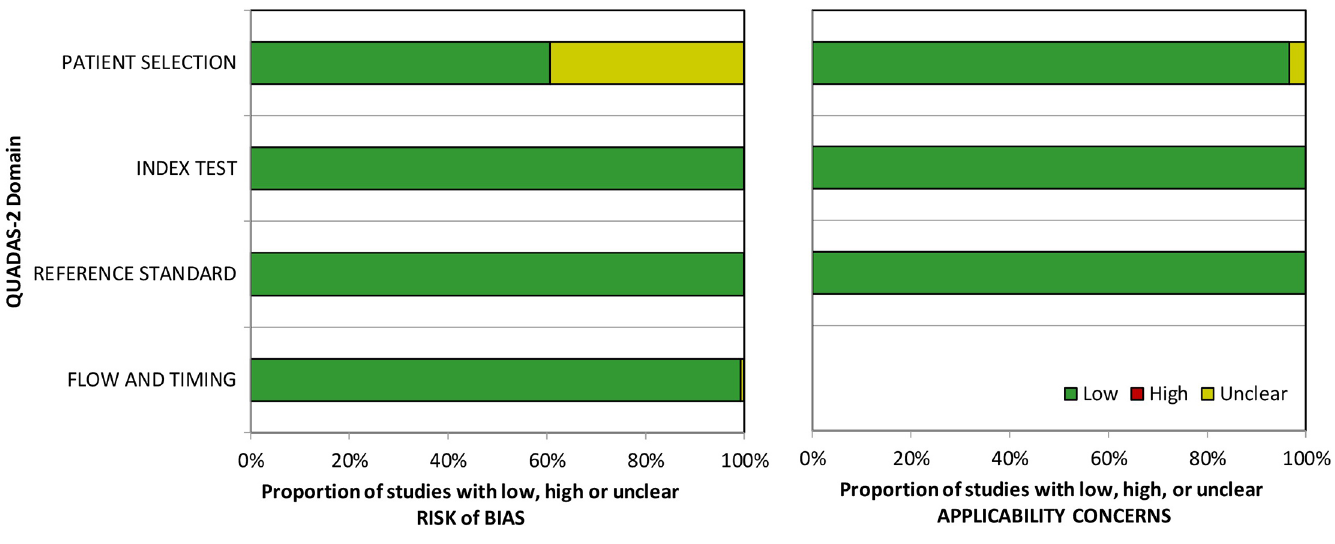
Fig 2. Methodological quality of included studies using the QUADAS 2